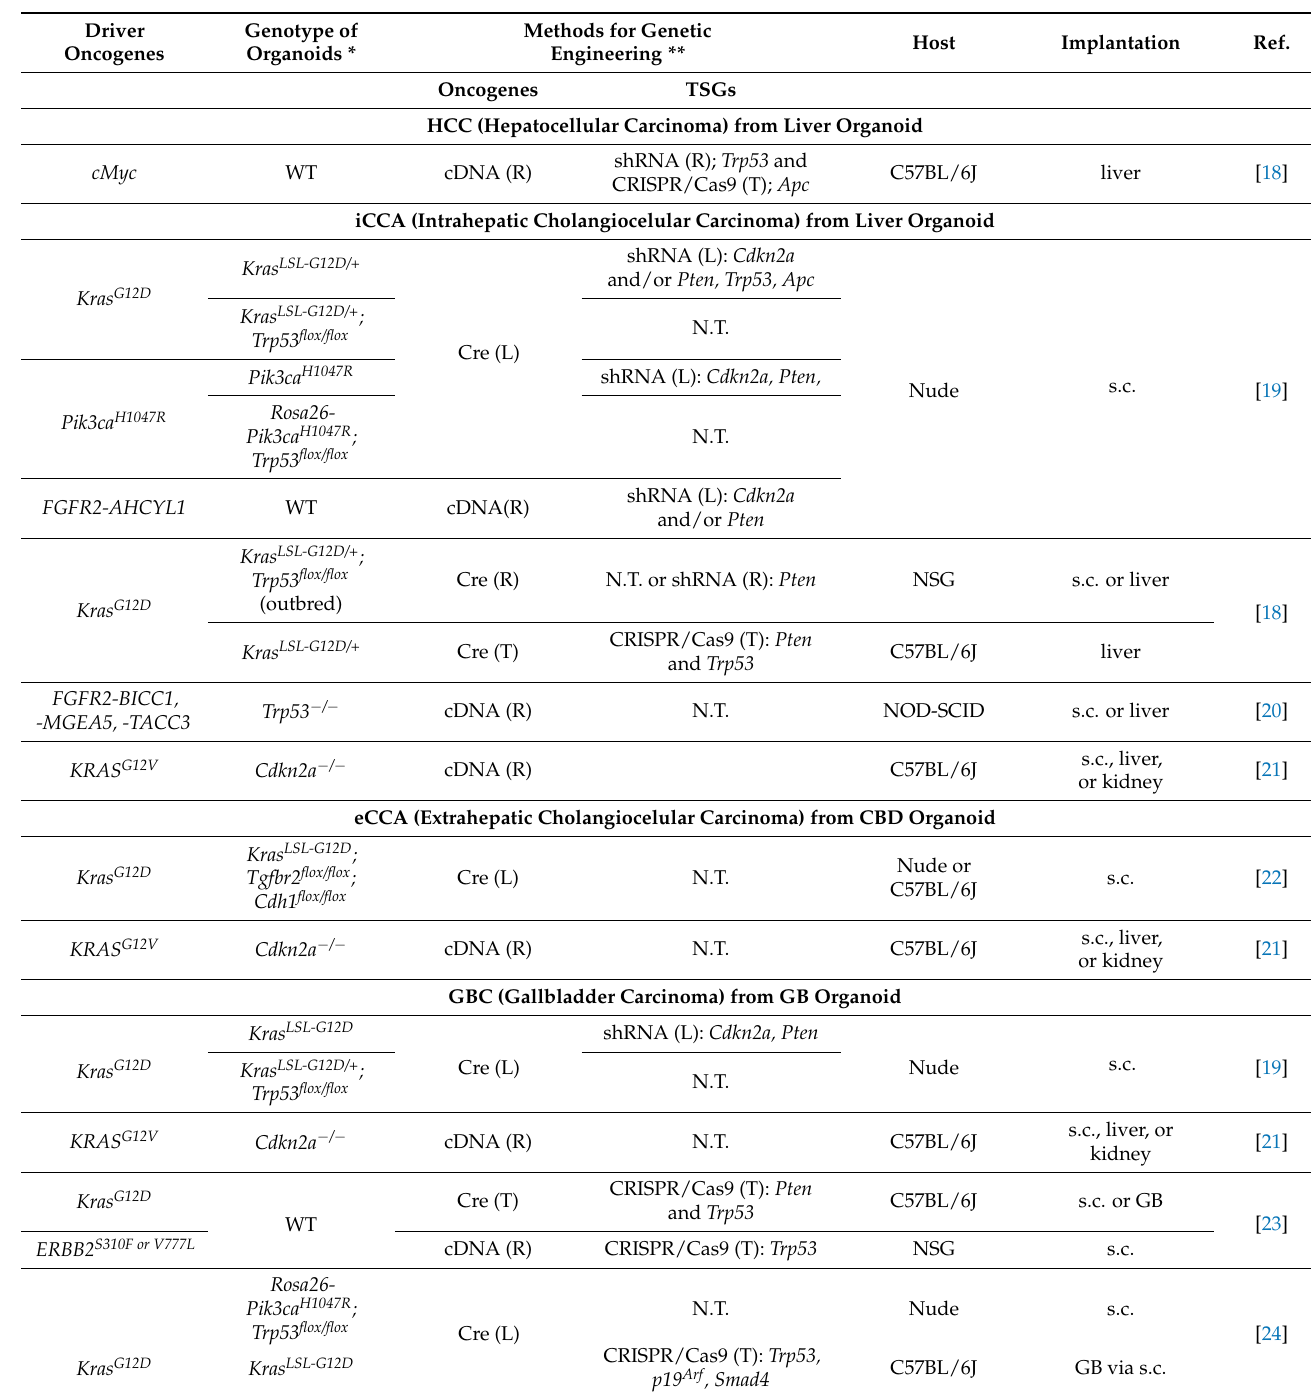
Table 1. Implantation- and organoid-based hybrid model of biliary tract cancer in mice. Driver